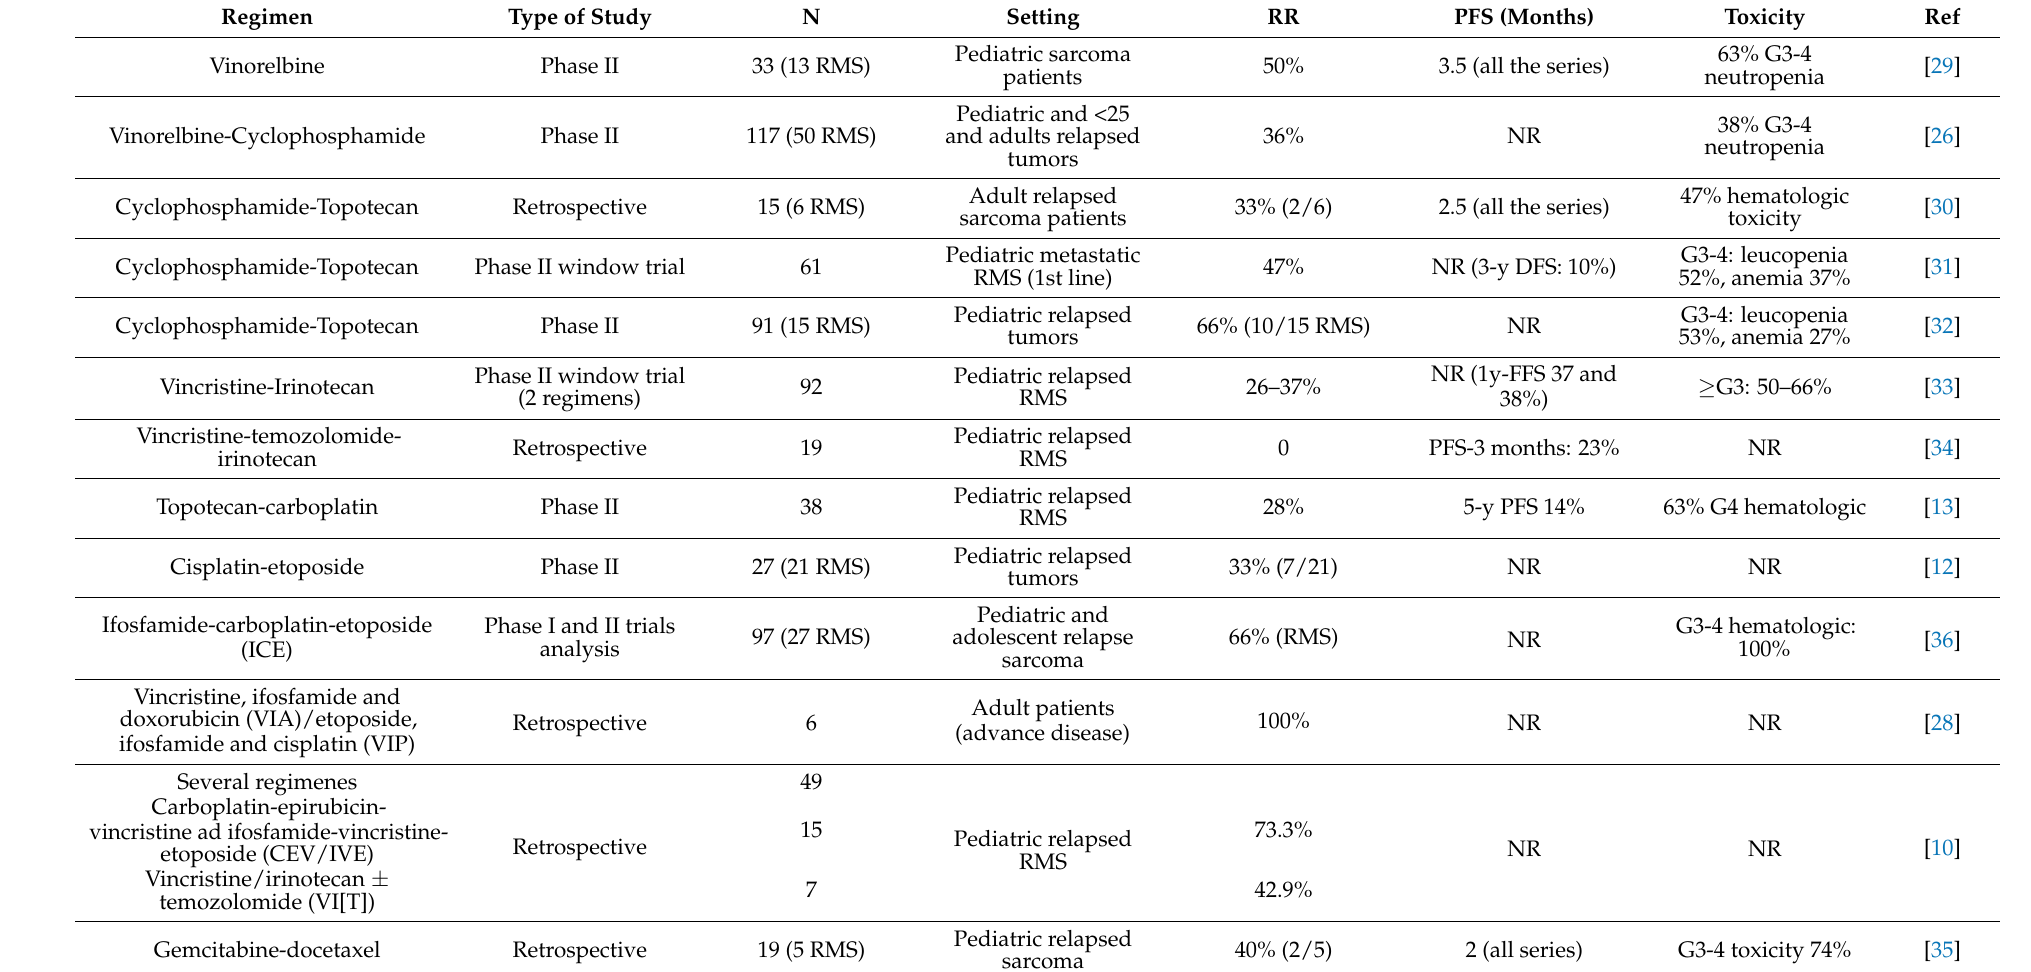
Table 5. Published evidence of second-line systemic therapy in